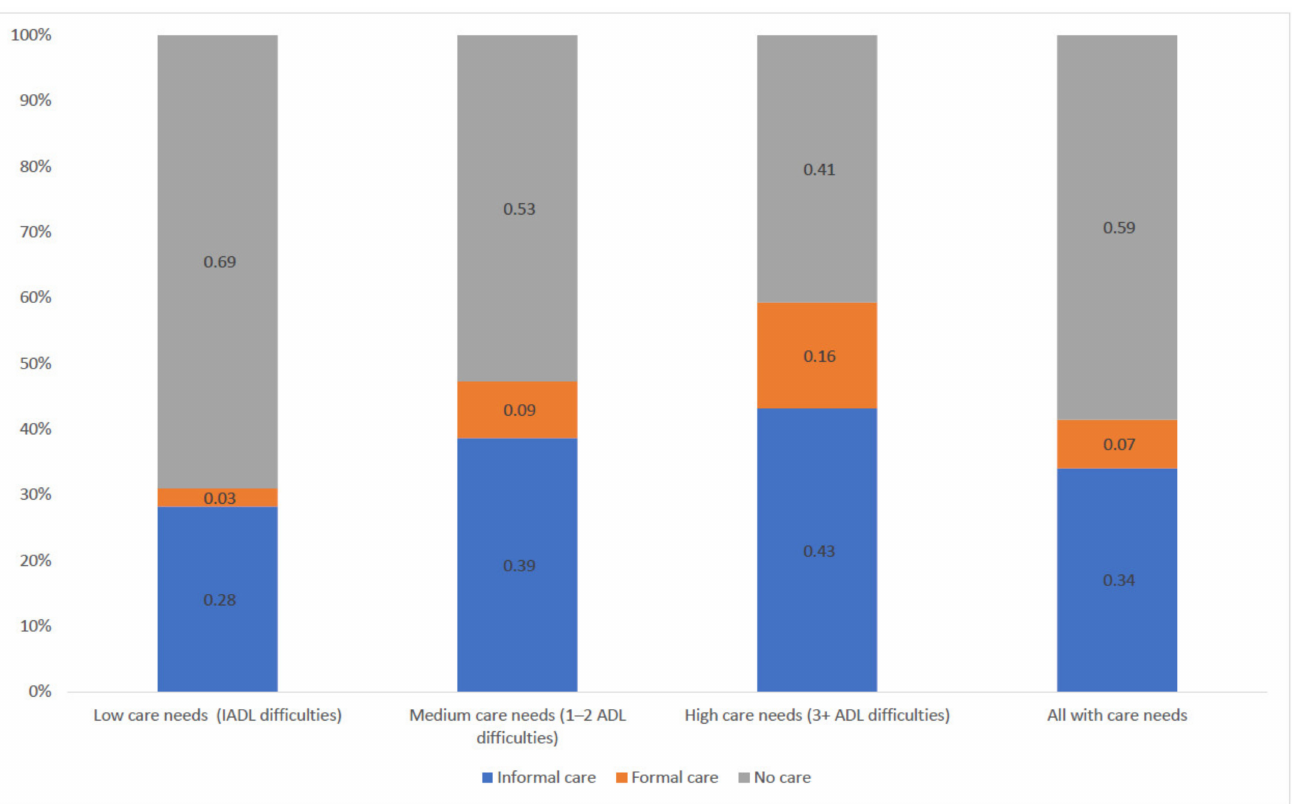
Figure 1. Predicted probability of receiving informal or formal care by levels of care